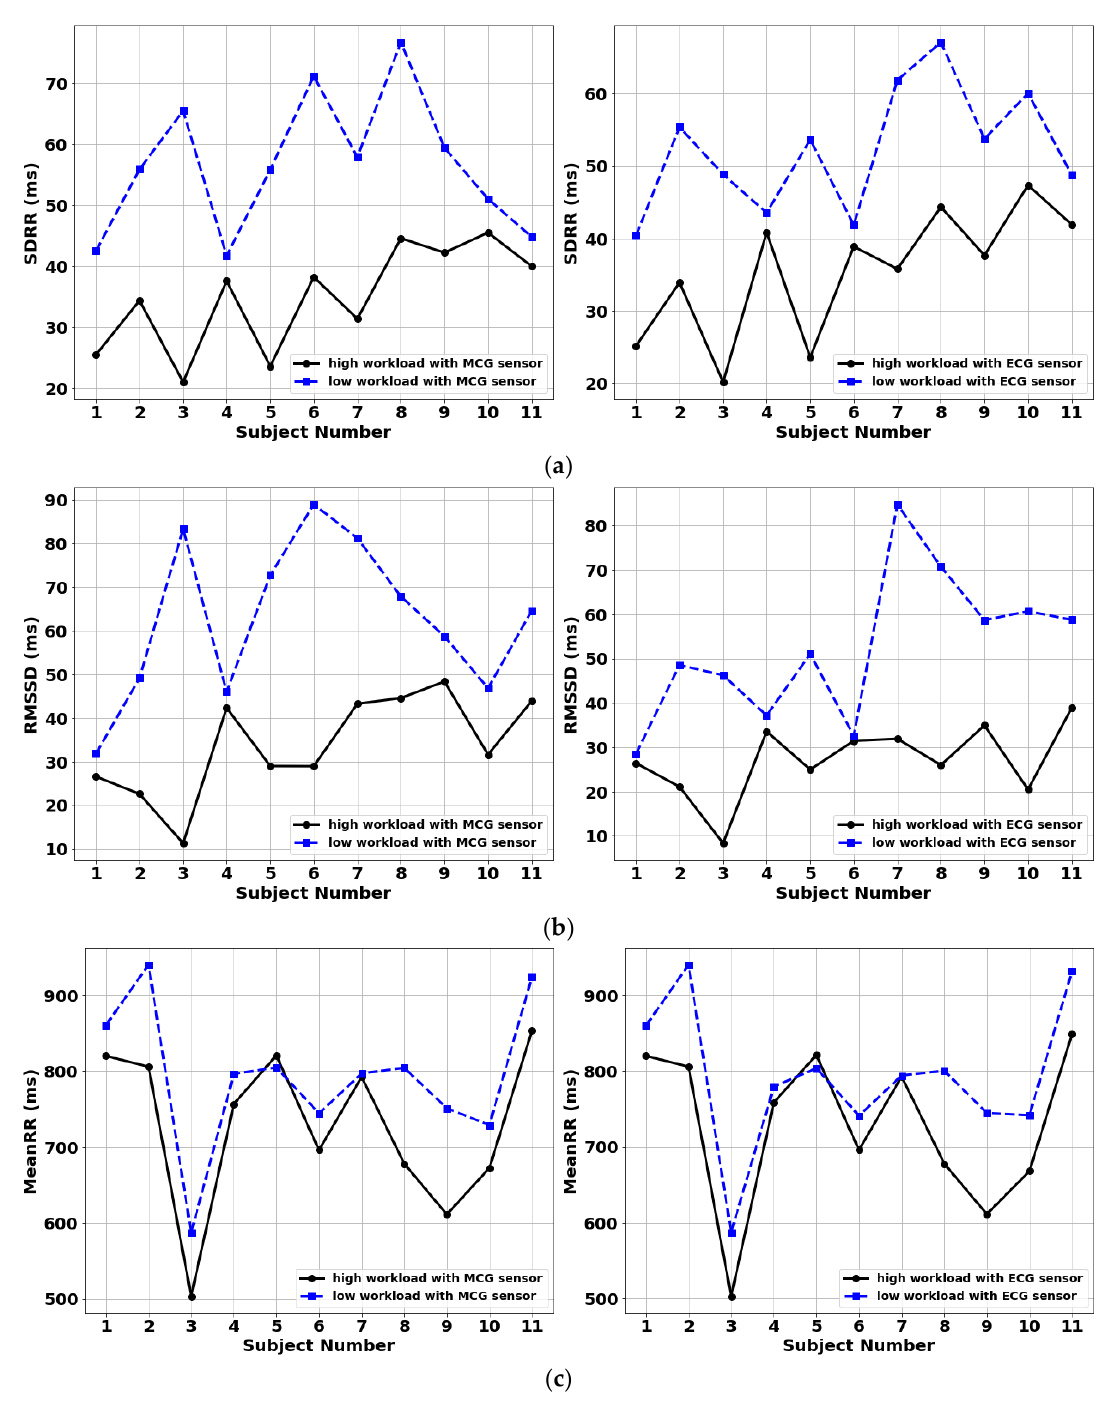
Figure 3. Comparison of HRV parameters for 11 participants under low (blue-dashed) and high (black-solid) cognitive workload conditions: ( a ) SDRR, ( b ) RMSSD and ( c ) MeanRR. MCG-derived metrics are shown to the left, and ECG-derived metrics are shown to the right.